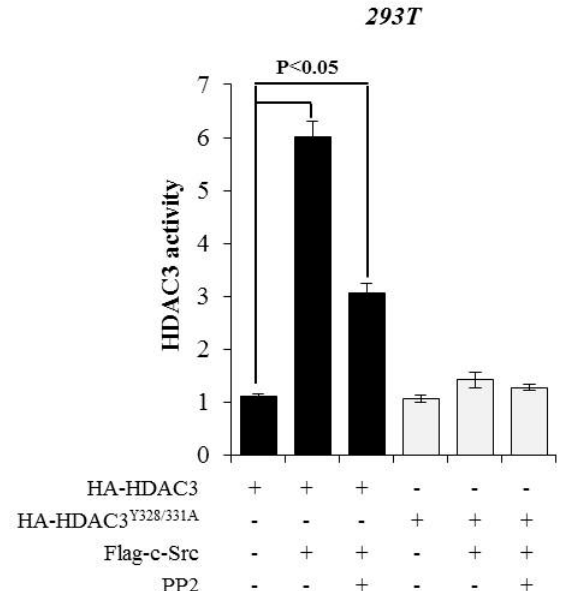
Figure 3. c-Src-mediated phosphorylation of HDAC3 affects its enzymatic activity. Mutations of Y328 and Y331 on HDAC3 inhibited its enzymatic activity. 293T cells were transfected with plasmids encoding either HA-tagged HDAC3 WT or HA-tagged HDAC3 Y328 / 331A . Cell extracts were immunoprecipitated with anti-HA antibody and assayed for histone deacetylase (HDAC) activity. The results were expressed as fold changes in optical density (OD) values relative to OD values of control (HA-HDAC3-overexpressing cells). The values presented are the means independent